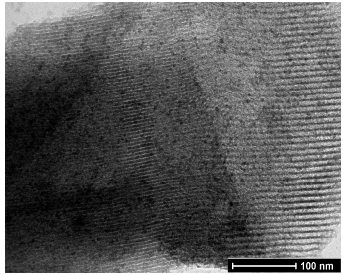
Figure 1. TEM micrograph of FeNP@SBA-15 material.